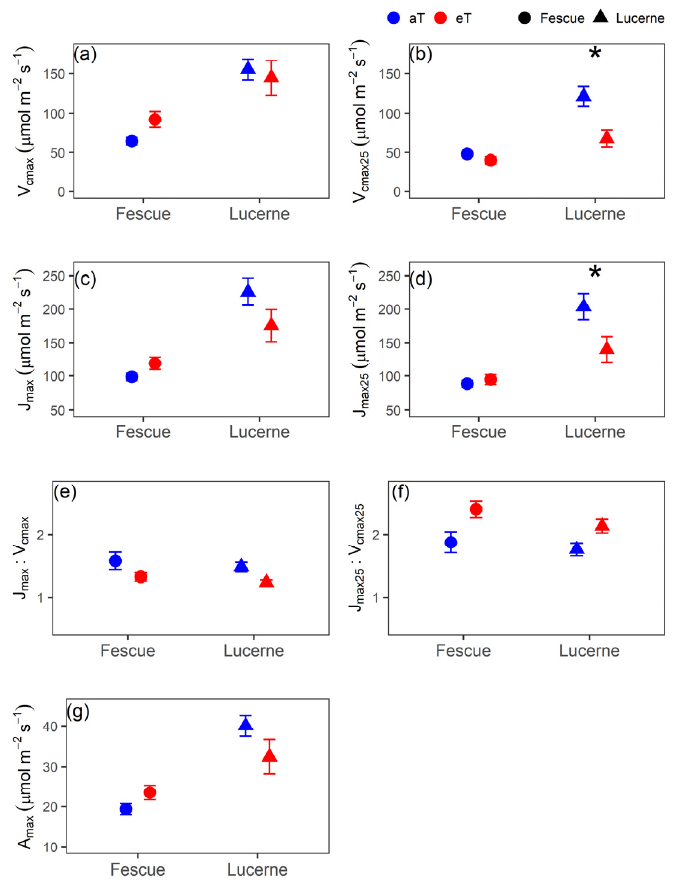
Figure 3. Maximum rate of carboxylation by Rubisco (V cmax ) at growth temperature ( a ) and at 25 ◦ C ( b ). Maximum rate of electron transport (J max ) at measurement temperature ( c ) and at 25 ◦ C ( d ). Ratio of J max to V cmax at measurement temperature ( e ) and at 25 ◦ C ( f ). ( g ) Maximum rates of light saturated photosynthesis at saturating [CO 2 ] (1500 ppm) (A max ). Values shown are means for tall fescue (circles) and lucerne (triangles) grown under 26 ◦ C (aT, blue) and 30 ◦ C (eT, red). Error bars indicate ± standard error ( n = 6). Statistically significant di ff erences between temperature treatments are portrayed as * ( p < 0.05).